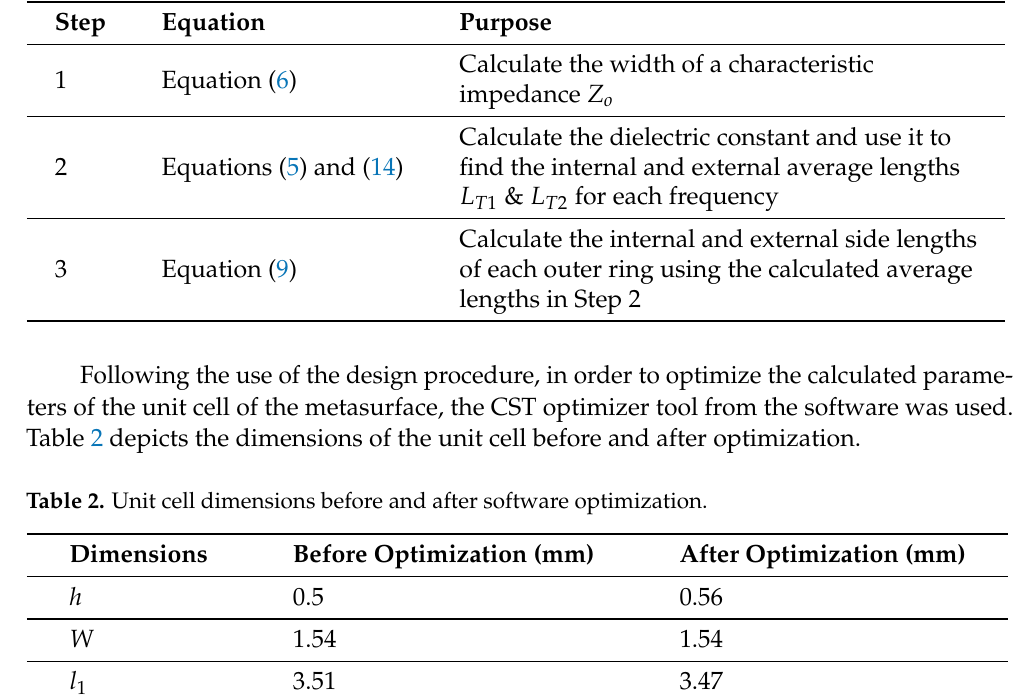
Table 1. Summary of calculation of dimensions of a metasurface unit cell.